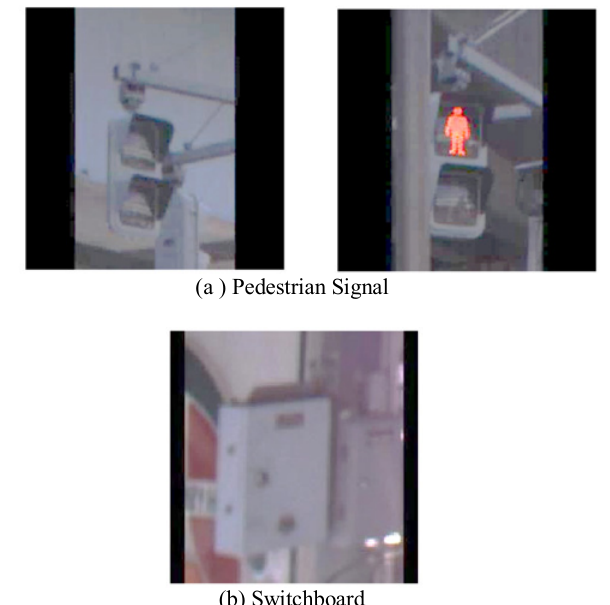
Figure 15: An example incorrectly